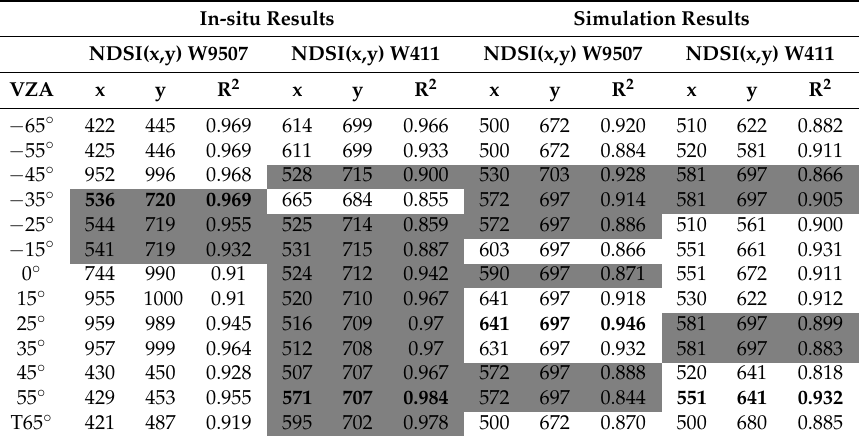
Table A1. Band combination of NDSI that shows the maximum R 2 for the linear relationship with LAI at each view angle, excluding results due to chance, for each wheat plant